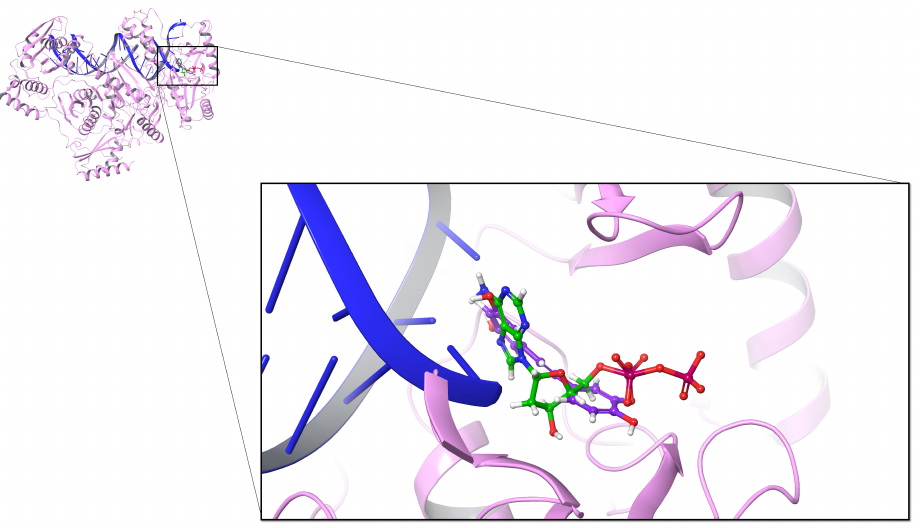
Figure 5. Superposition of two docking poses of trans -resveratrol (purple) and dATP (green) on HIV-1 reverse transcriptase (PDB ID: